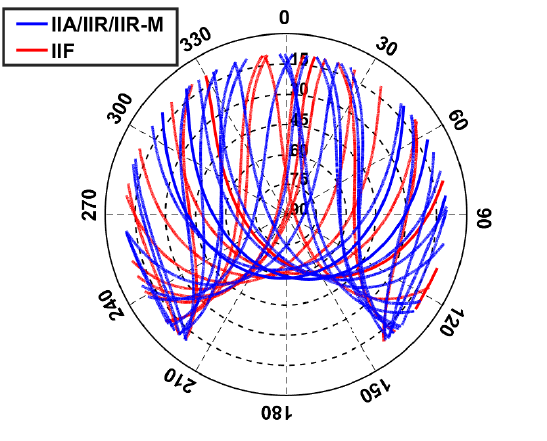
Figure 2. Skyplot of the visible GPS satellites for station CUAA over 24 h on DOY 240,